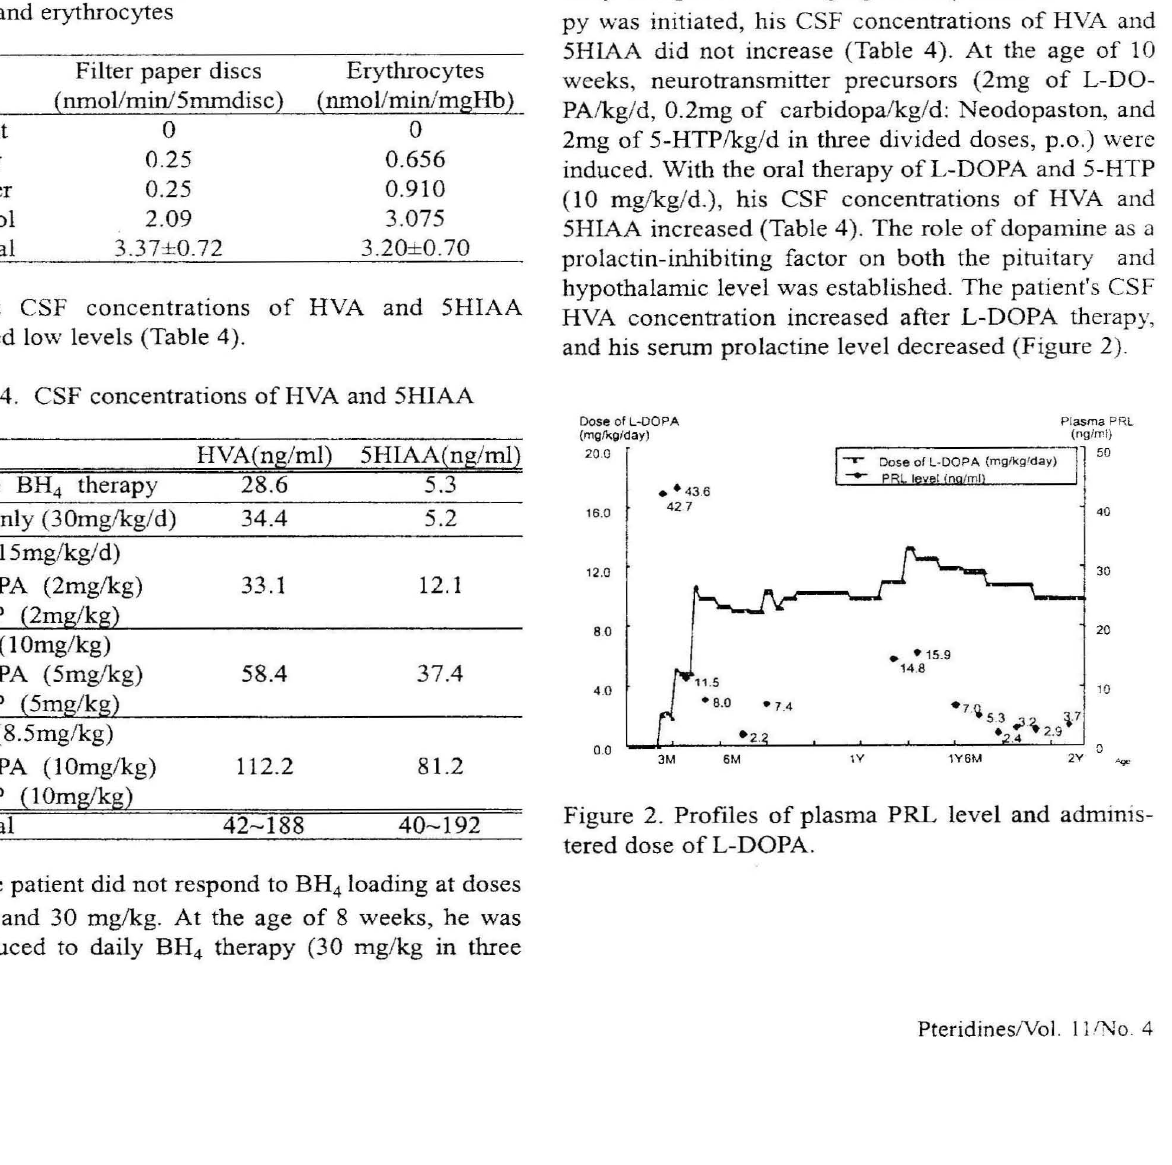
Figure 2. Profiles of plasma PRL level and adminis tered dose of